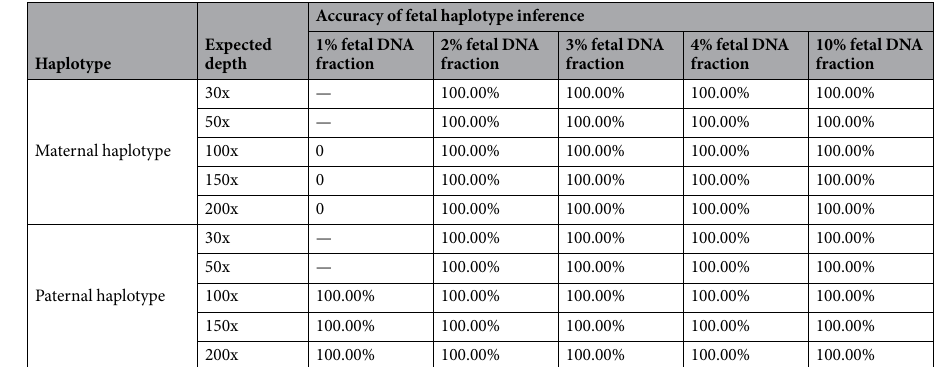
Table 2. Effect of fetal DNA fraction and sequencing depth on the accuracy of the fetal haplotype inference in artificial mixtures.